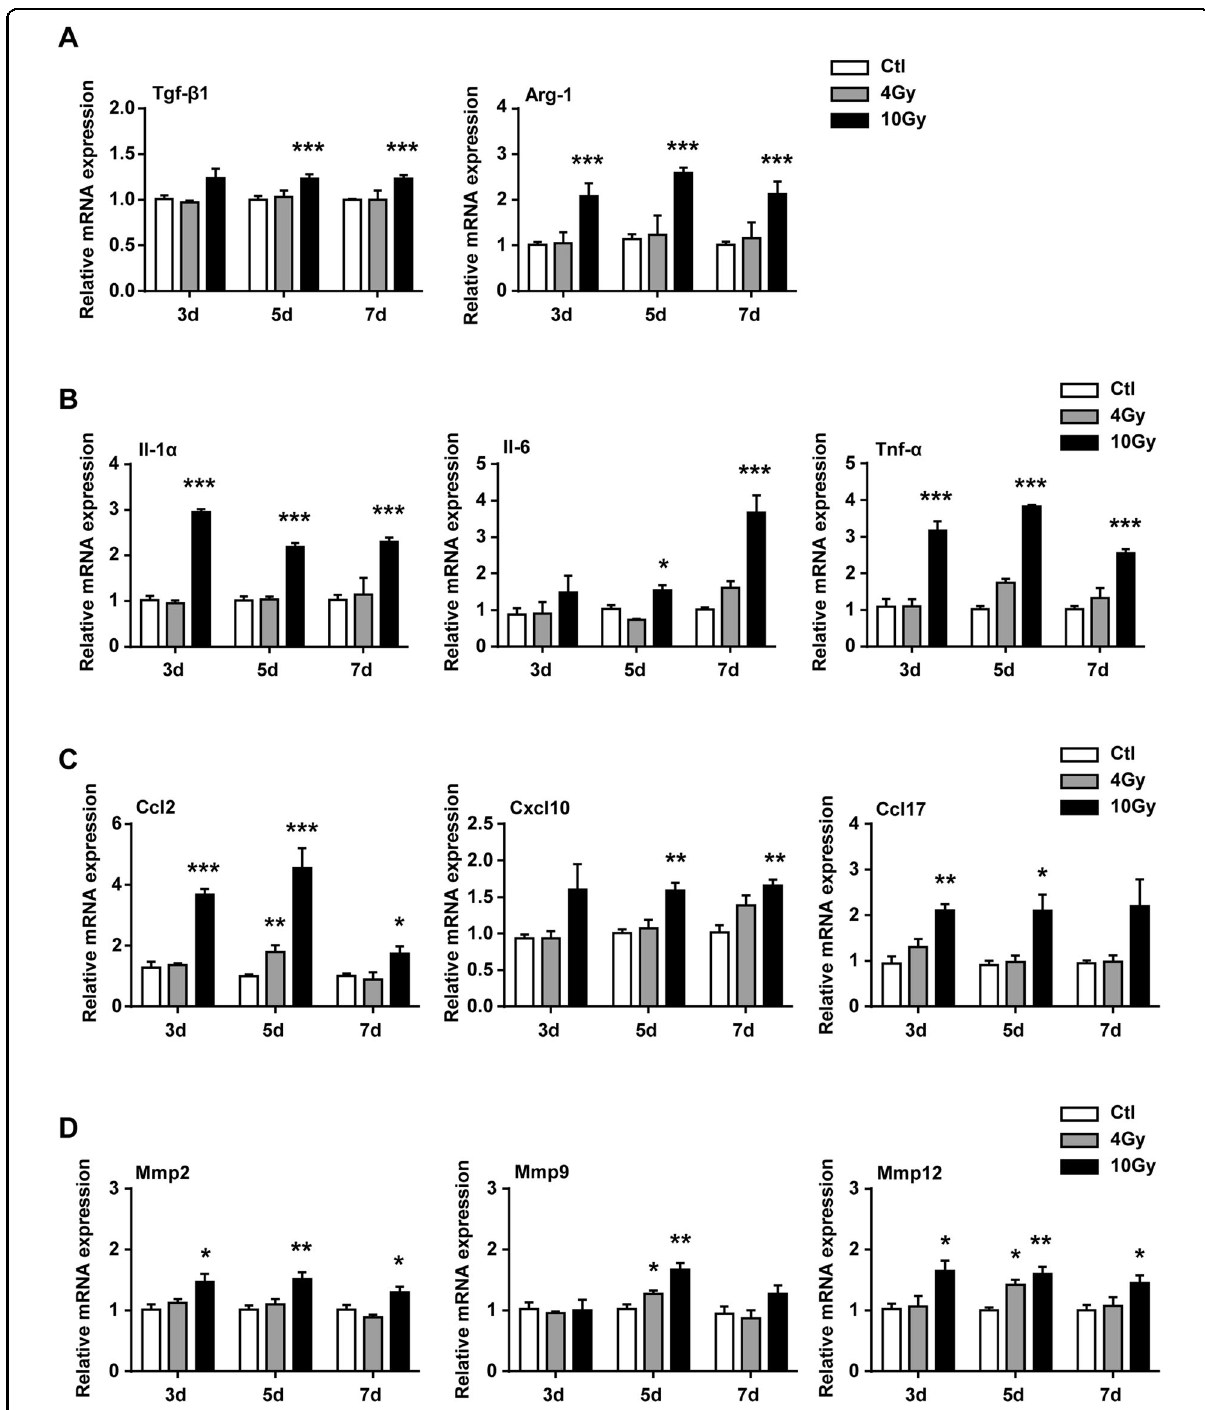
Fig. 2 Elevated expression of fi brotic genes and SASP genes in senescent BMMs. BMMs were exposed to IR at doses of 0 (ctl), 4, or 10 Gy. BMMs were collected at intervals after IR and in controls. The expression of A fi brotic genes (Tgf- β 1 and Arg-1), B SASP proin fl ammatory factors genes (Il-1 α , Il-6, and Tnf- α ), C SASP chemokines genes (Ccl2, Cxcl10, and Ccl17), D SASP Mmps genes (Mmp2, Mmp9, and Mmp12) were quanti fi ed by qRT – PCR and were expressed relative to Gapdh levels in BMMs. Data are expressed as mean ± SEM of fi ve independent experiments, *** P < 0.001, ** P < 0.01, and * P < 0.05 compared with the corresponding